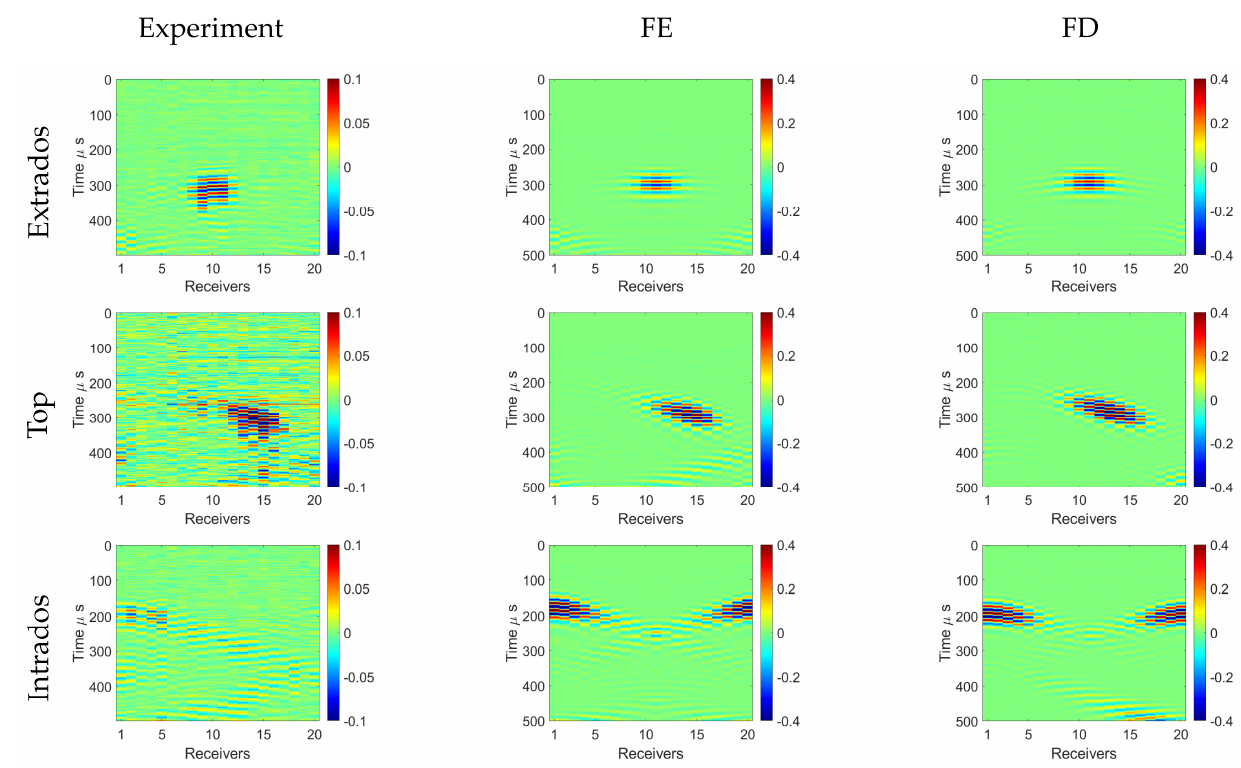
Figure 10. Experimental, FE, and FD scattered wave fields in the bend when the excitation sources and defects were located at three different positions: extrados, top, and intrados. Plasticine was used for producing scattered waves in the experiment, and a Hann-shaped defect was modeled in FE and FD